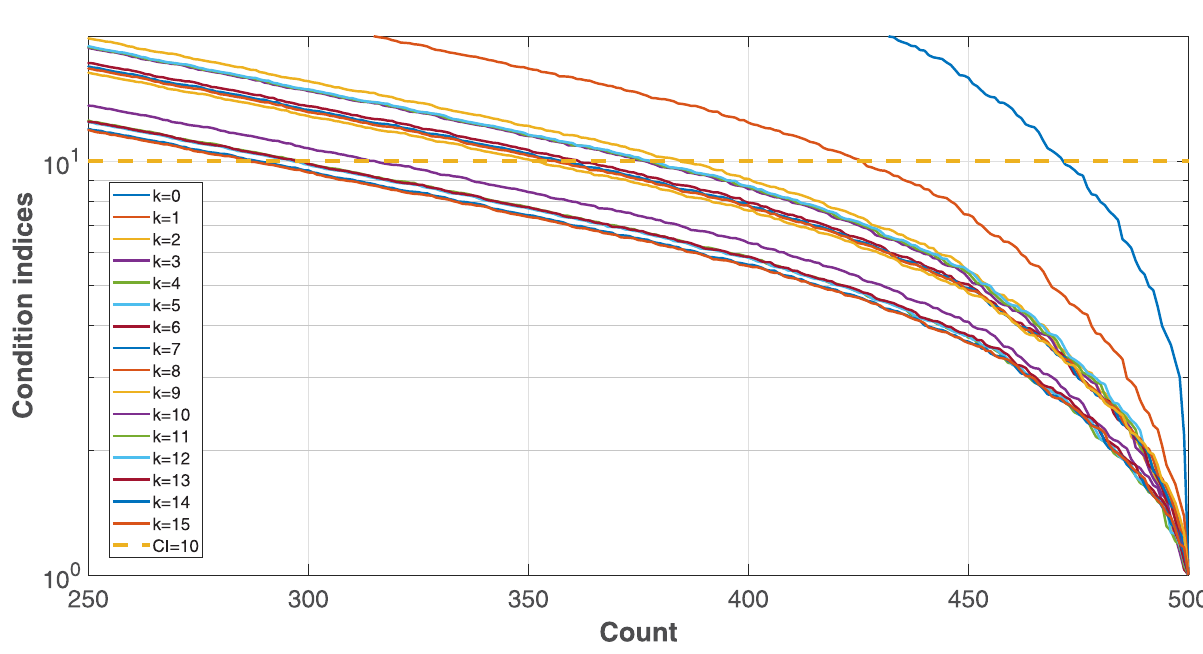
Fig 7. CI measurement results with different projection direction